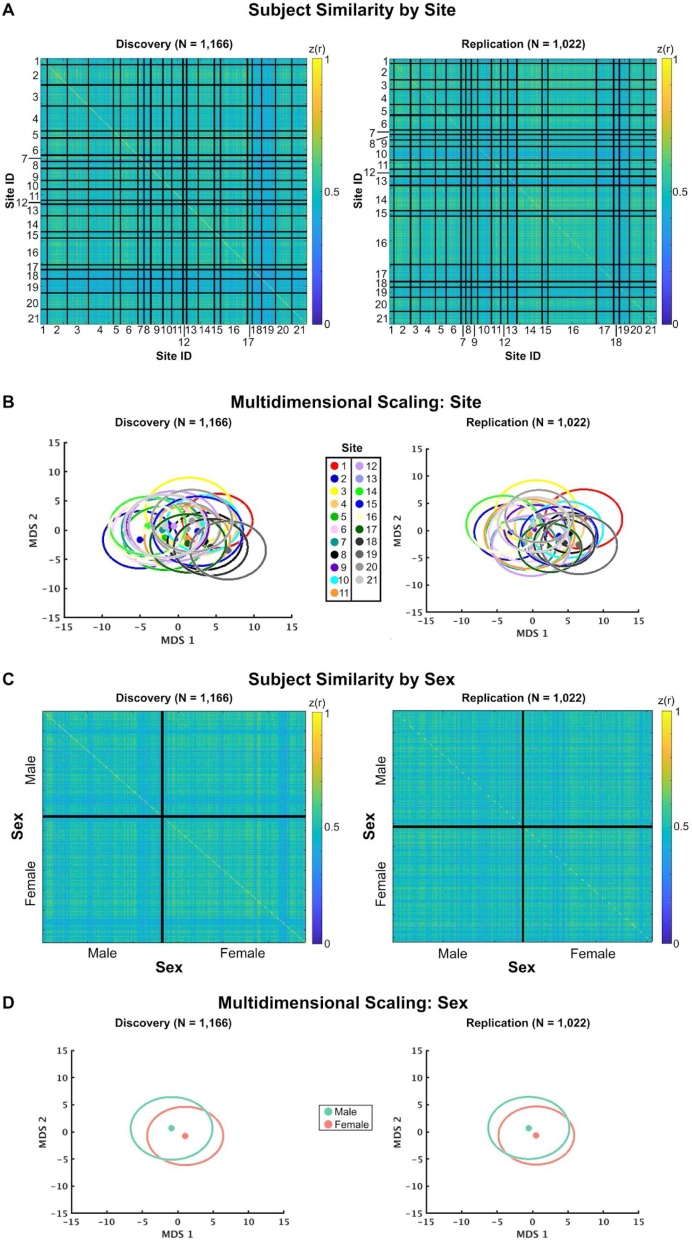
Effects of scanning site and sex are small. (A & C) RSFC similarity across individuals, sorted by scanning site (A) and sex (C). Note the strong homogeneity in similarity across scanning sites and sex, indicating a lack of evidence for whole brain site and sex effects. On average, sites 18 and 19 demonstrated the lowest similarity to other scanning sites. (B & D) Each data point represents the mean across participants in multidimensional space, colored by the scanner site in (B) and sex in (D). Circles around the data points represent the 2-dimensional standard error of the mean in multidimensional space. Scanner site and sex were not clearly captured within these dimensions, suggesting a lack of evidence for whole brain site effects and sex effects for ABCD resting-state data.